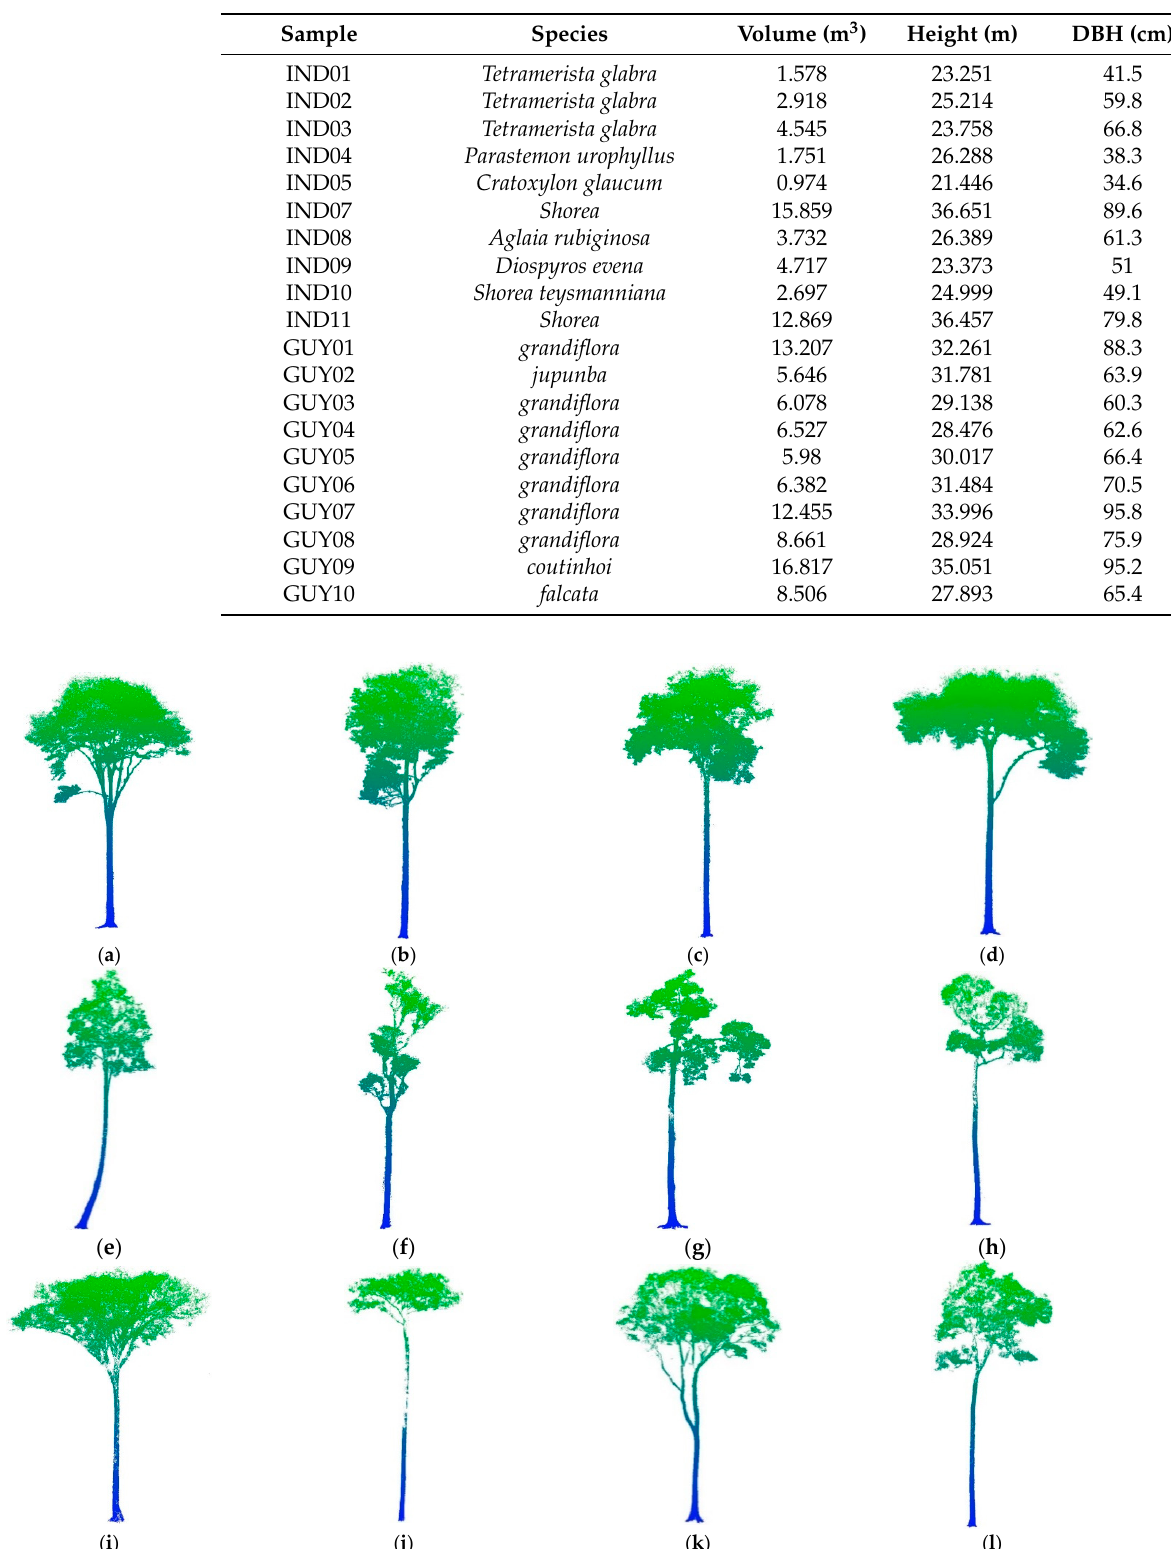
Figure 12. Tree samples for the three forest sites. ( a – d ) tree samples from Peruvian site; ( e – h ) tree samples from Indonesian site; ( i – l ) tree samples from Guyanese site.